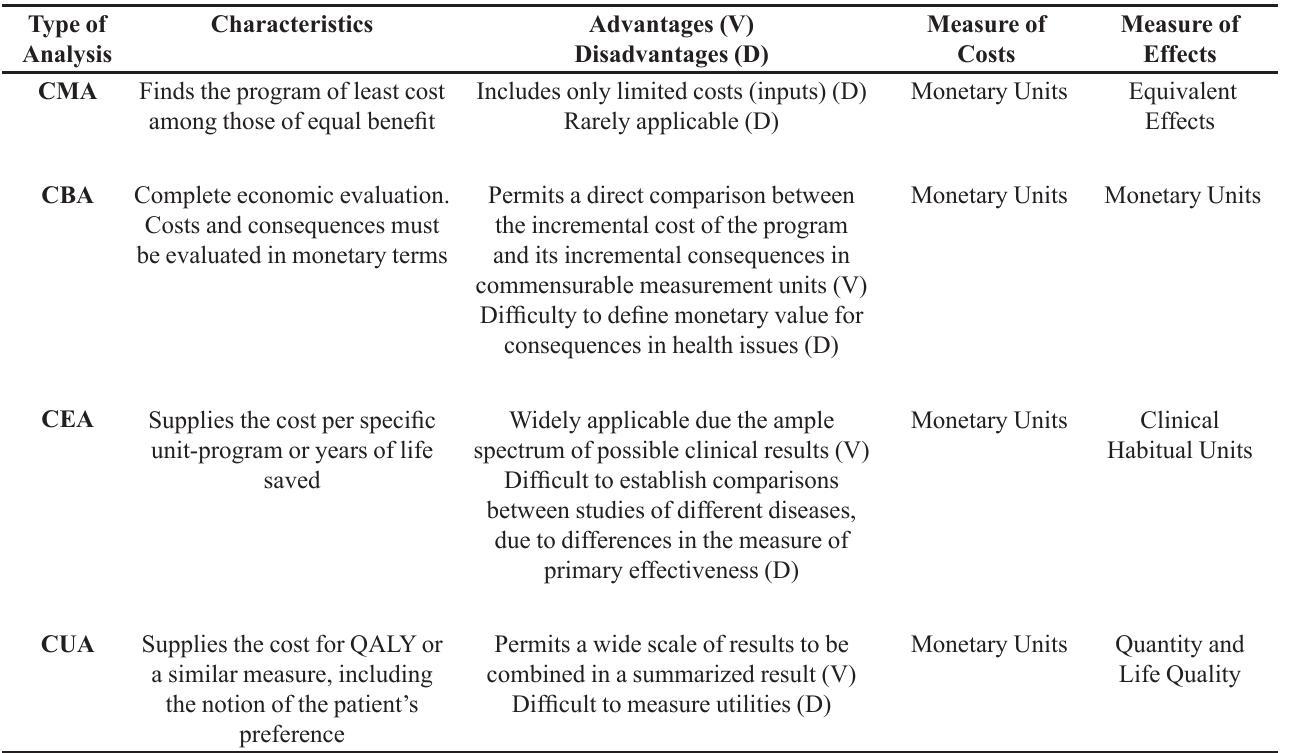
TABLE I - Types of pharmacoeconomic analysis Type of